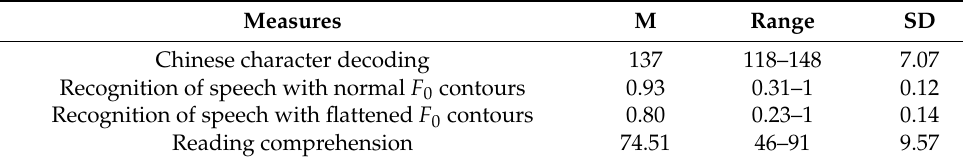
Table 1. Means, ranges, and standard deviations of each